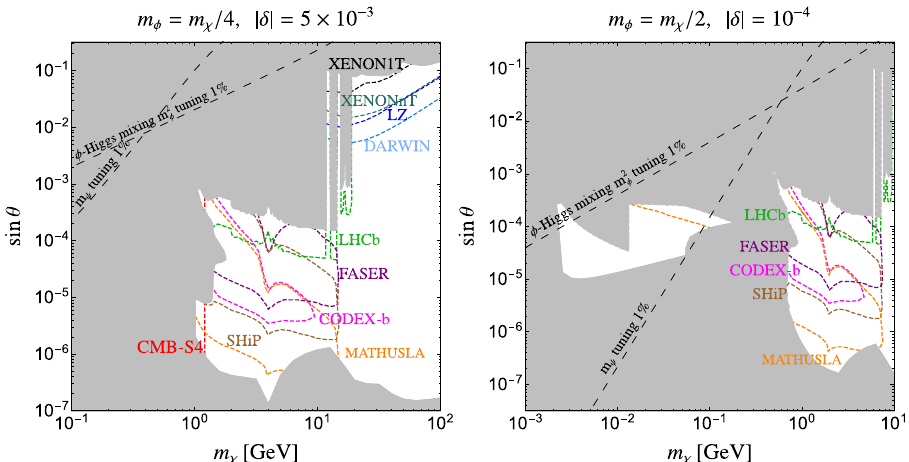
δ = 5 × 10 − 3 e i π/ 4 , with δ ≡ δ m / m χ . Right: The remaining param- eters are set instead as y = e i π/ 4 , m φ = m χ / 2 and δ = 10 − 4 e i π/ 4 . MATHUSLA sensitivity is shown for the 200 m × 200 m configura- tion, while FASER sensitivity is shown for the 1 m radius configuration, now referred to as